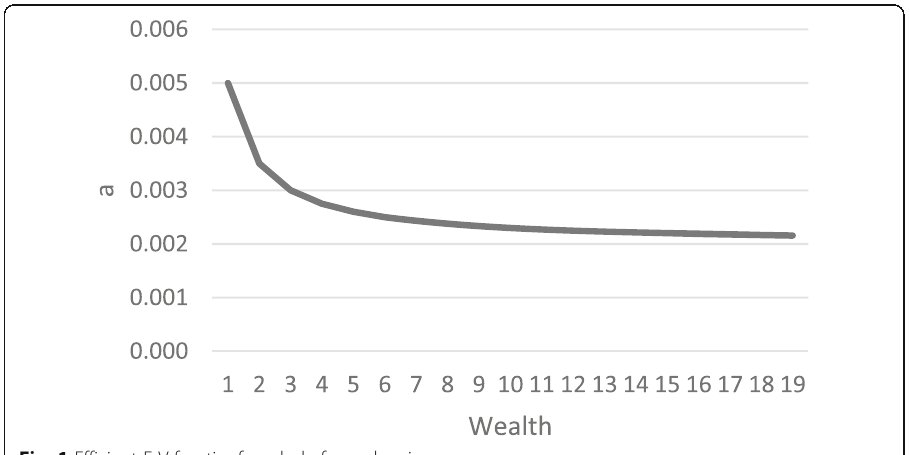
Fig. 1 Efficient E-V frontier for whole farm